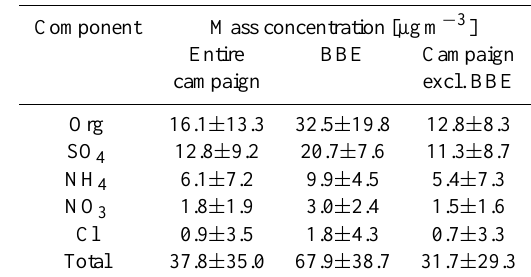
Table 2. Average mass concentrations of organic matter and in- organic ions (arithmetic mean values ± standard deviation) as ob- tained from AMS measurements integrated over a mobility equiv- alent particle size range of 50–850nm for the entire campaign, for the biomass burning event (BBE), and for the campaign excluding the